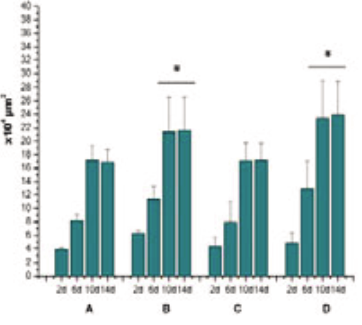
FIGURE 4 – Number of newly formed blood vessels (n/10 4 µm 2 )